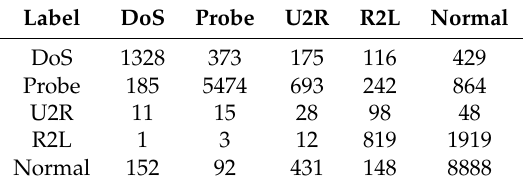
Table 9. Confusion matrix of BP.